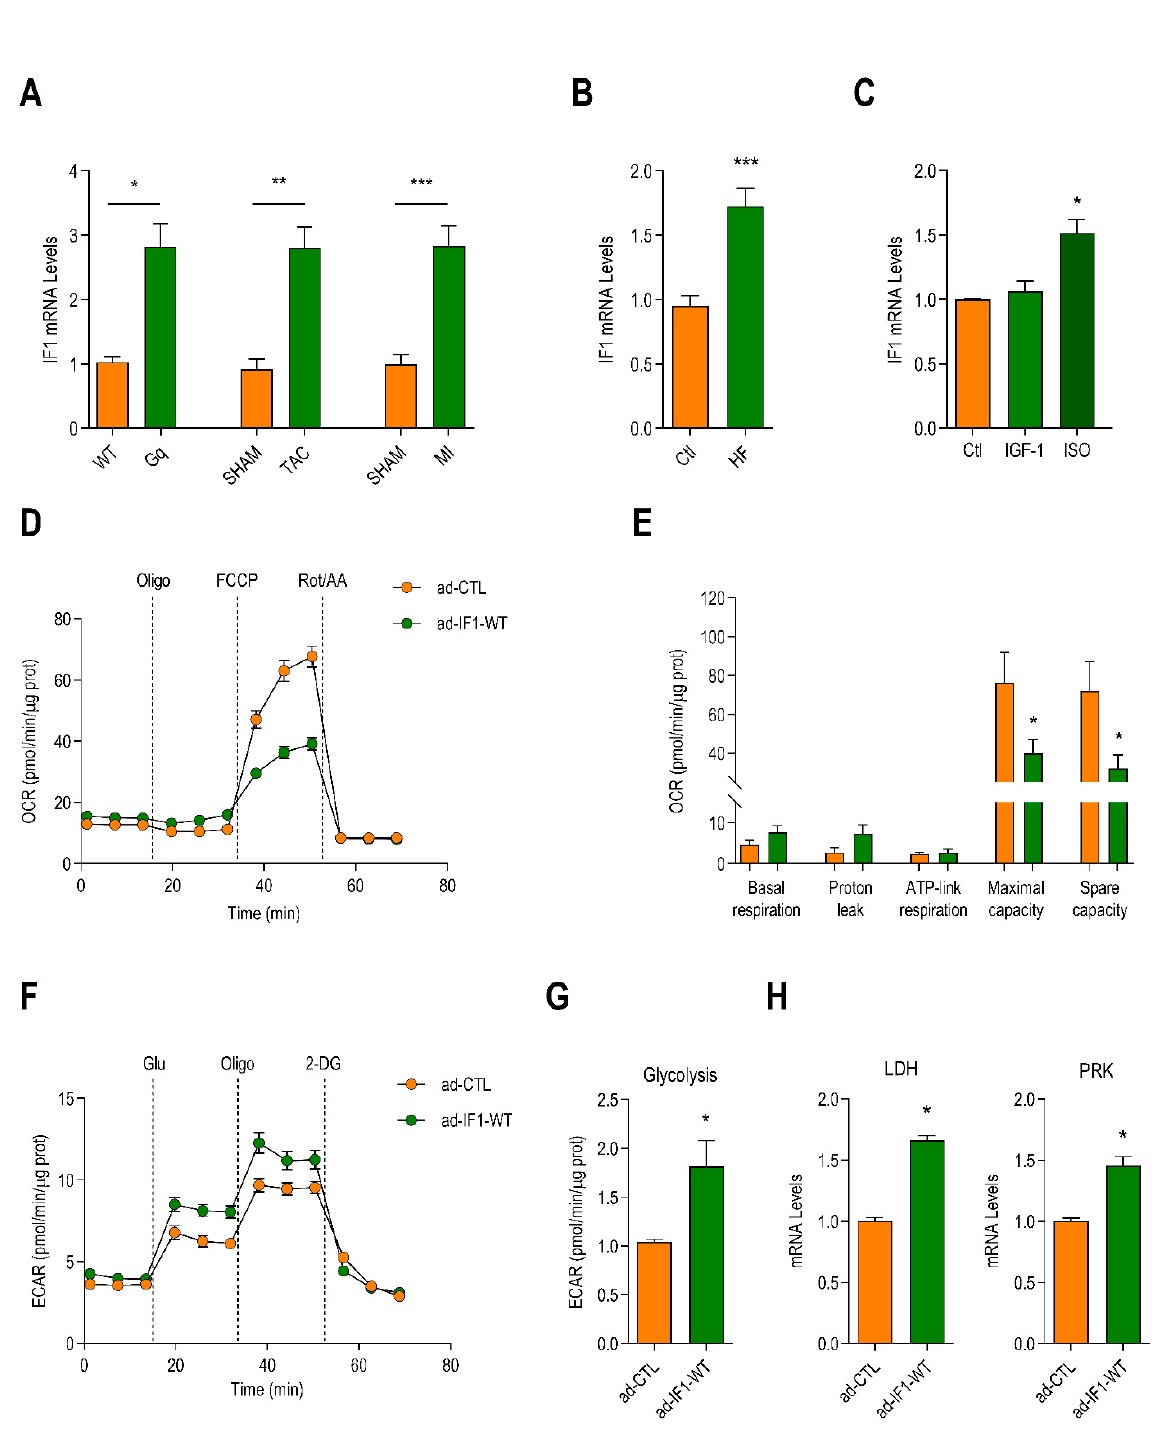
Figure 1. Expression of ATPase inhibitory factor-1 (IF1) is increased in heart failure, decreases mitochondrial respiratory capacity, and promotes glycolysis in cardiomyocytes. ( A ) IF1 mRNA levels in mice with heart failure induced by cardiomyocyte autonomous expression of G α q and wild-type (WT) littermate controls ( n = 4), and mice with heart failure induced by transverse aortic constriction (TAC) ( n = 6) or myocardial infarction (MI) ( n = 6) surgeries and sham-operated controls (SHAM). ( B ) mRNA expression of IF1 in cardiac lysates from patients with end-stage heart failure and normal control hearts ( n = 11). ( C ) IF1 mRNA expression in neonatal rat ventricular myocytes (NRVMs) treated with insulin-like growth factor-1 (IGF-1, 10 nM), isoproterenol (ISO, 100 nM) or vehicle (Ctl) for 48 h ( n = 4). ( D ) Neonatal rat ventricular myocytes (NRVMs) were infected with an adenoviral vector expressing human IF1 (ad-IF1-WT) or a control virus expressing green fluorescent protein (GFP) (ad-CTL) for 48 h. The line graph depicts changes in the oxygen consumption rate (OCR) of NRVMs after serial treatments with oligomycin (oligo), FCCP, and rot + AA assessed with the Seahorse system. The graph represents five independent experiments. ( E ) Bar graph depicting differences in basal respiration,